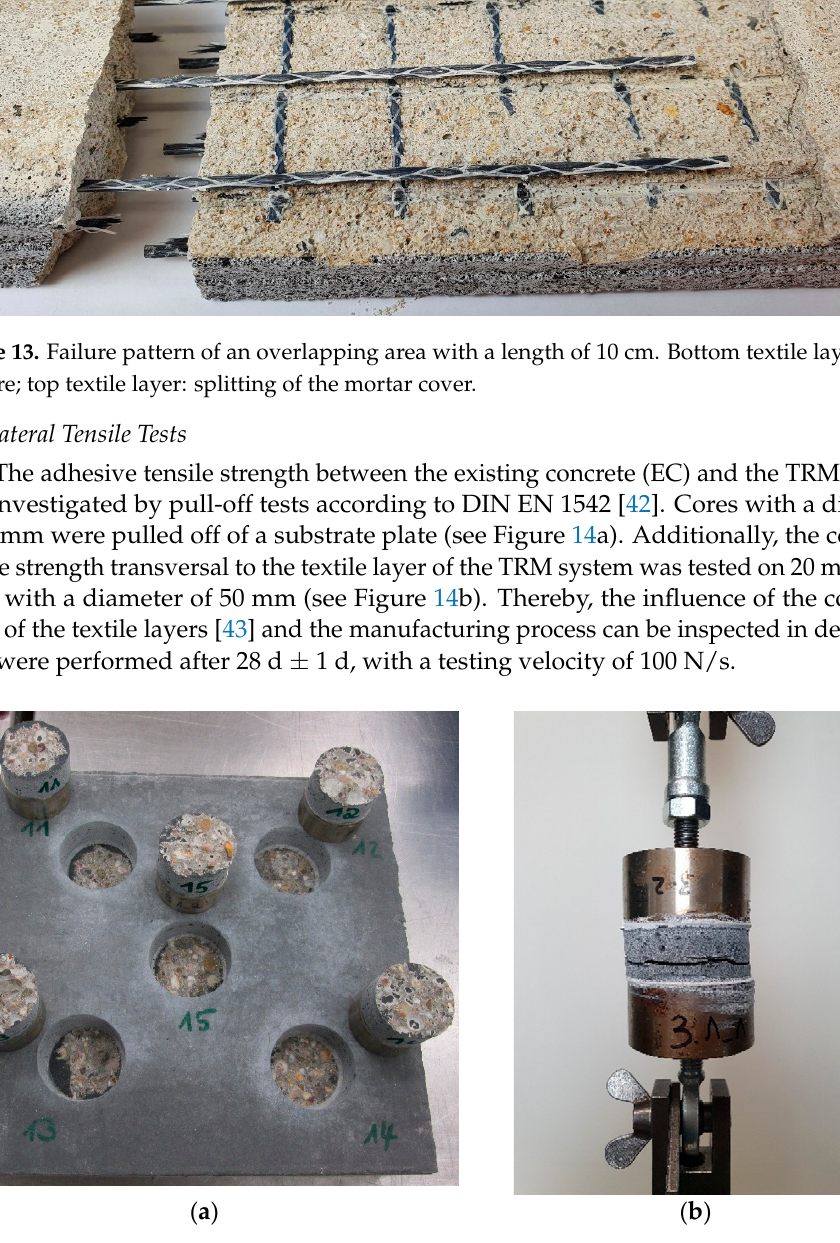
Figure 15. Tensile strengths of the existing concrete ( σ EC ) and the repair mortars ( σ M1 ‐ T1C and σ M2 ‐ T1C ), as well as the adhesive tensile strength between the concrete and repair mortar ( σ Adh ‐ M1 and σ Adh ‐ M2 ); mean values of five single values, with standard deviation indicated.